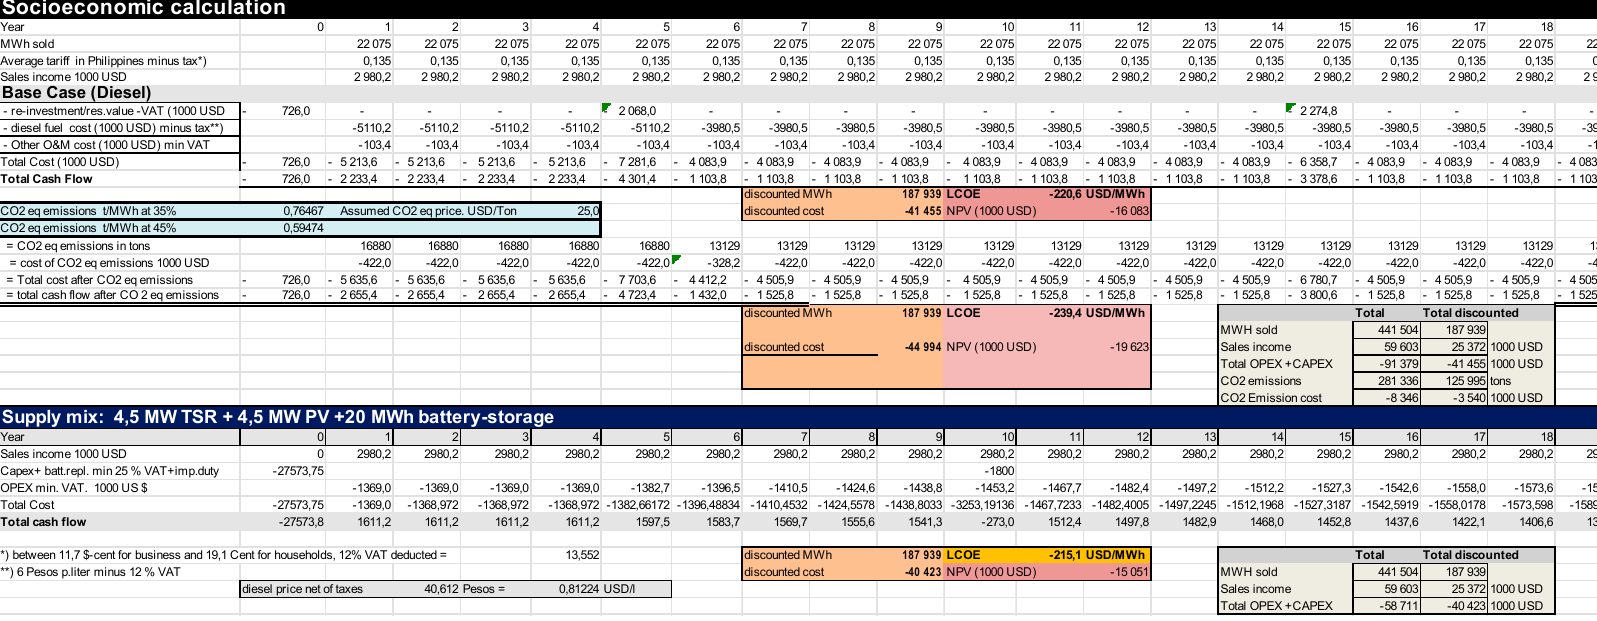
Figure A2. Socioeconomic calculation.